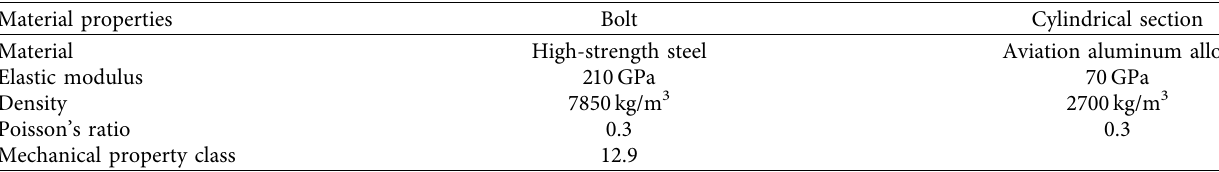
Figure 1: Simplified connection structure. Table 1: Material properties.